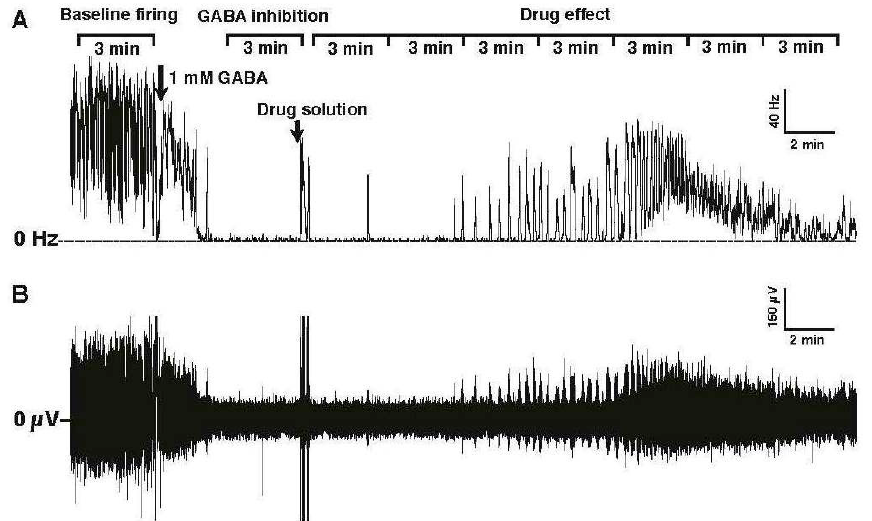
Figure 2. D. melanogaster larval CNS recordings and sampling for statistical analysis. ( A ) Nerve firing displayed as a frequency of spikes/s (Hz). For statistical analysis, baseline firing frequency and nerve discharge inhibited by 1 mM GABA were calculated by averaging over 3-min periods as shown in the figure. The drug-induced nerve firing rate was averaged over 3-min periods after treatment; ( B ) Nerve firing of the same preparation displayed as a voltage